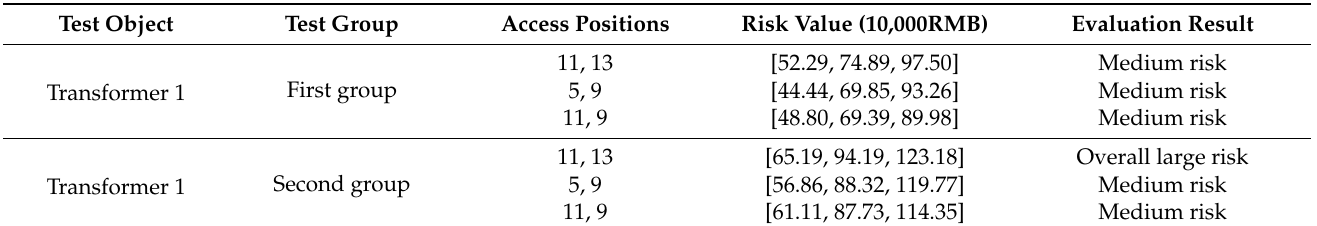
Table 15. Comparison of evaluation results of different wind turbines access